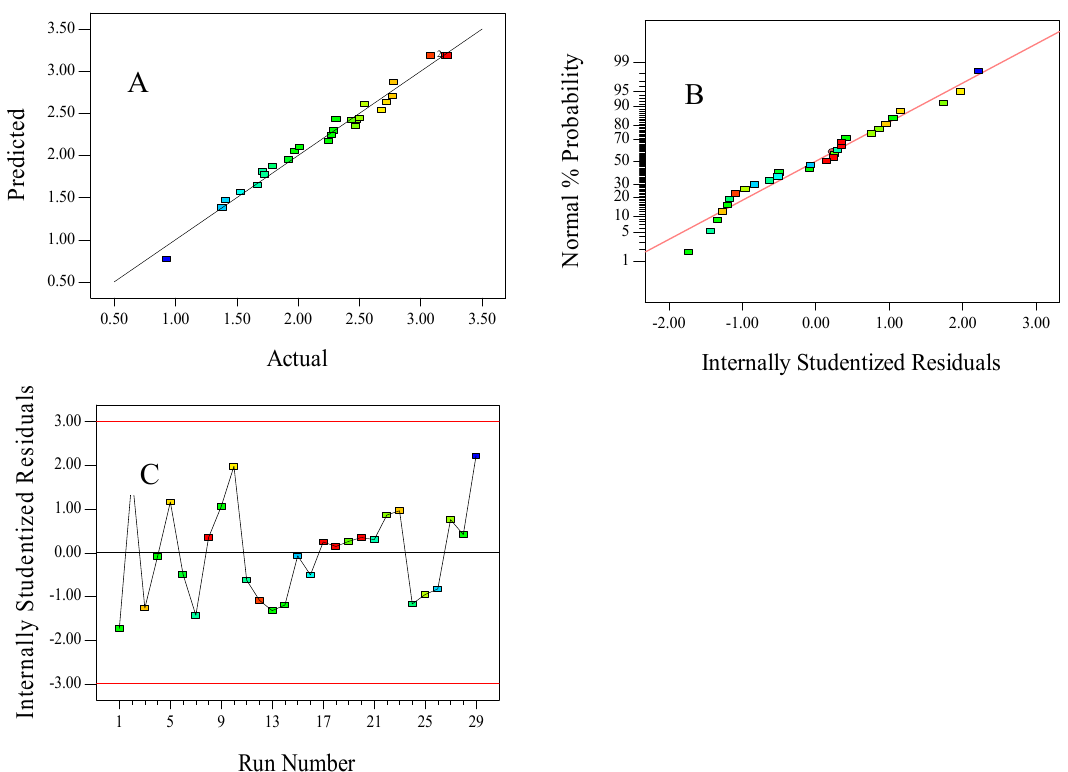
Figure 2. Estimation of the model precision. ( A ) Plot of predicted and actual values; ( B ) The normal % probability plot; ( C ) Plot of internally studentized residuals versus actual run.